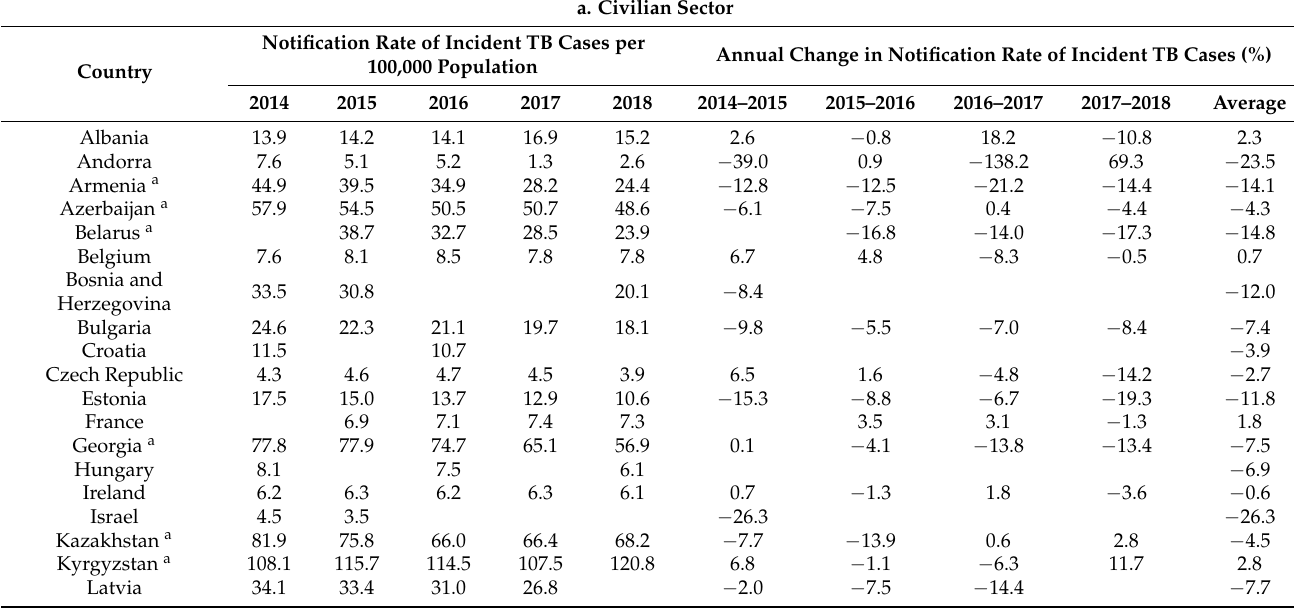
Table 2. Notification rate of incident TB cases and year-to-year percentage changes in TB notification rates, WHO Euro- pean Region, 2014–2018.